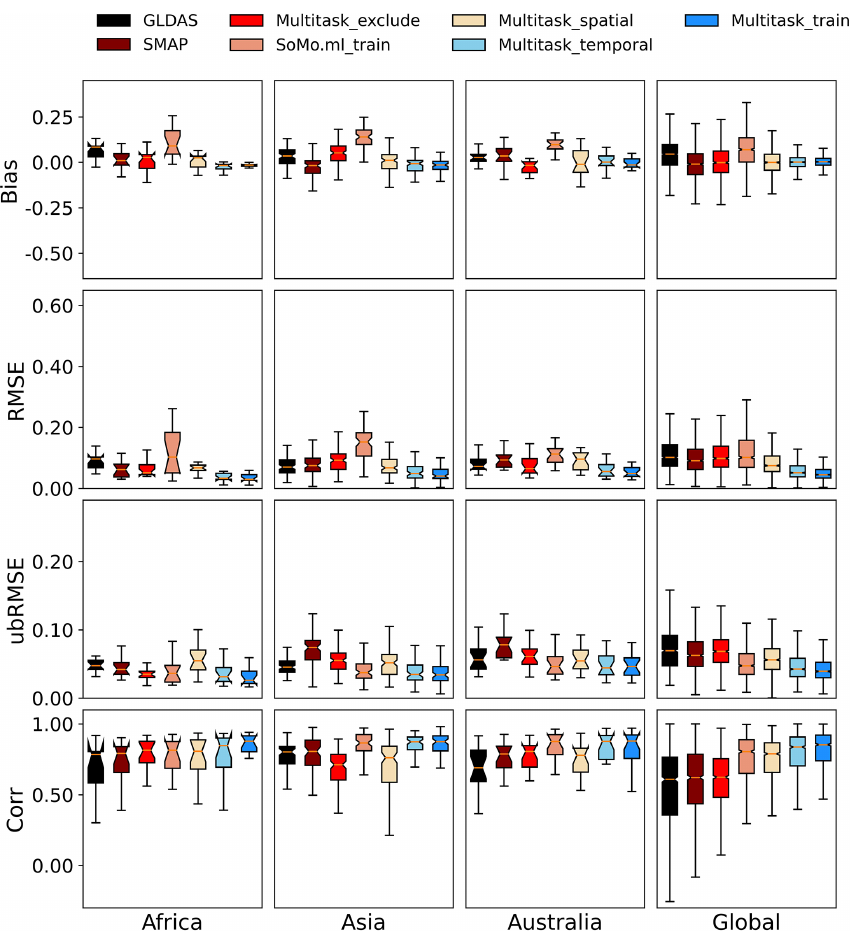
Figure 2. The same as Fig. 1 but for data-sparse regions, i.e., Africa, Asia, and Australia.